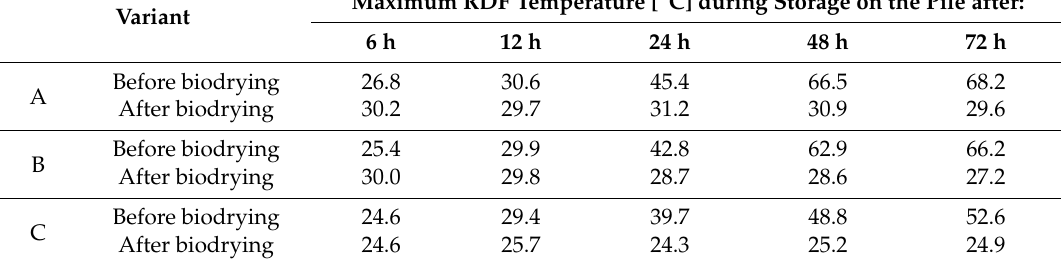
Table 4. Distribution of maximum temperatures achieved in the alternative fuel piles before and after the biological drying process ( ◦